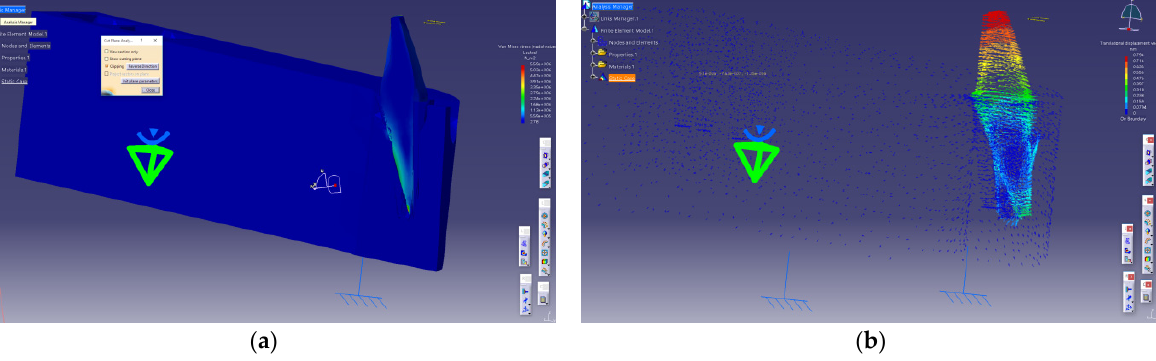
Figure 9. Lingualization of the LLI using a 1 N force: ( a ) von Mises tensions, 33% HBL; ( b ) tooth movement, 33% HBL.